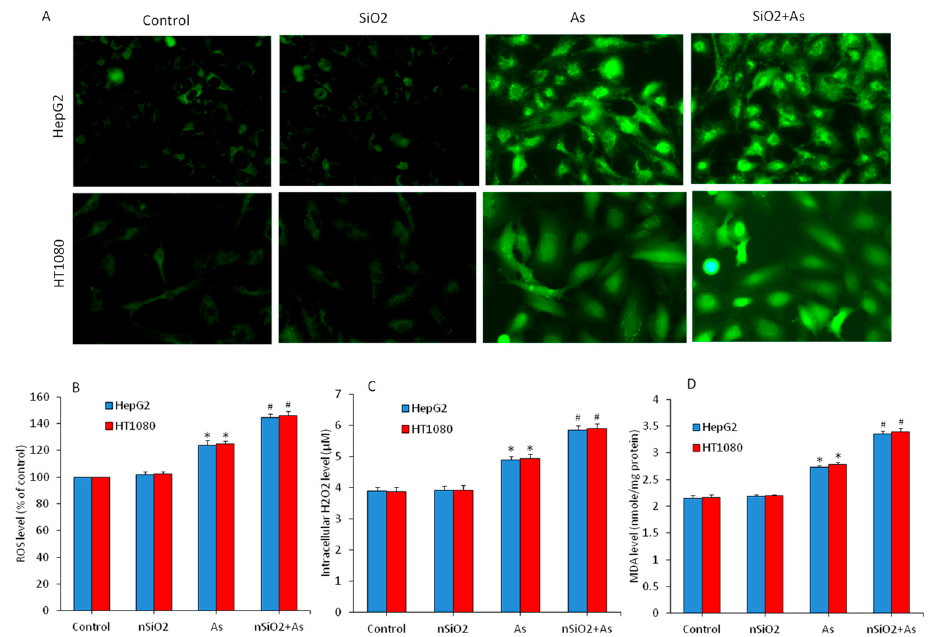
Figure 3. Pro-oxidant levels in HepG2 and HT1080 cells exposed for 24 h to nSiO 2 (10 µ g / mL), As (1 µ g / mL) or SiO 2 + As (10 µ g / mL + 1 µ g / mL) for 24 h. ( A ) Fluorescent microscopic images of intracellular reactive oxygen species (ROS) level. ( B ) Quantitative level of intracellular ROS level. ( C ) Intracellular H 2 O 2 level. ( D ) Malondialdehyde (MDA) level. Data are presented as the mean ±